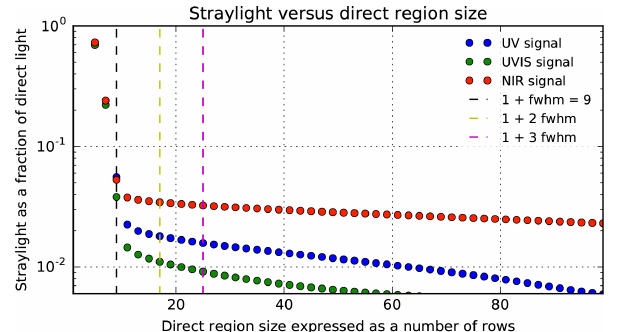
Figure 23. Shown is the integrated straylight fraction received per UVN detector as a function of the direct region size. The illumina- tion is via the Earth port. The NIR detector (red dots) displays the most straylight followed by the UV (blue dots) and the UVIS (green dots). The vertical dashed lines indicate the direct illumination in rows for three region sizes expressed in multiples of the FWHM of the direct signal. Shown are 1 + 1 × FWHM (black dashes), 1 + 2 × FWHM (yellow dashes), and 1 + 3 × FWHM (red dashes). The off- set of one row is the centre of mass of the column average of the direct signal.